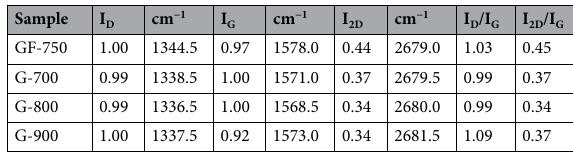
Table 3. D, G and 2D band data of Raman spectra.